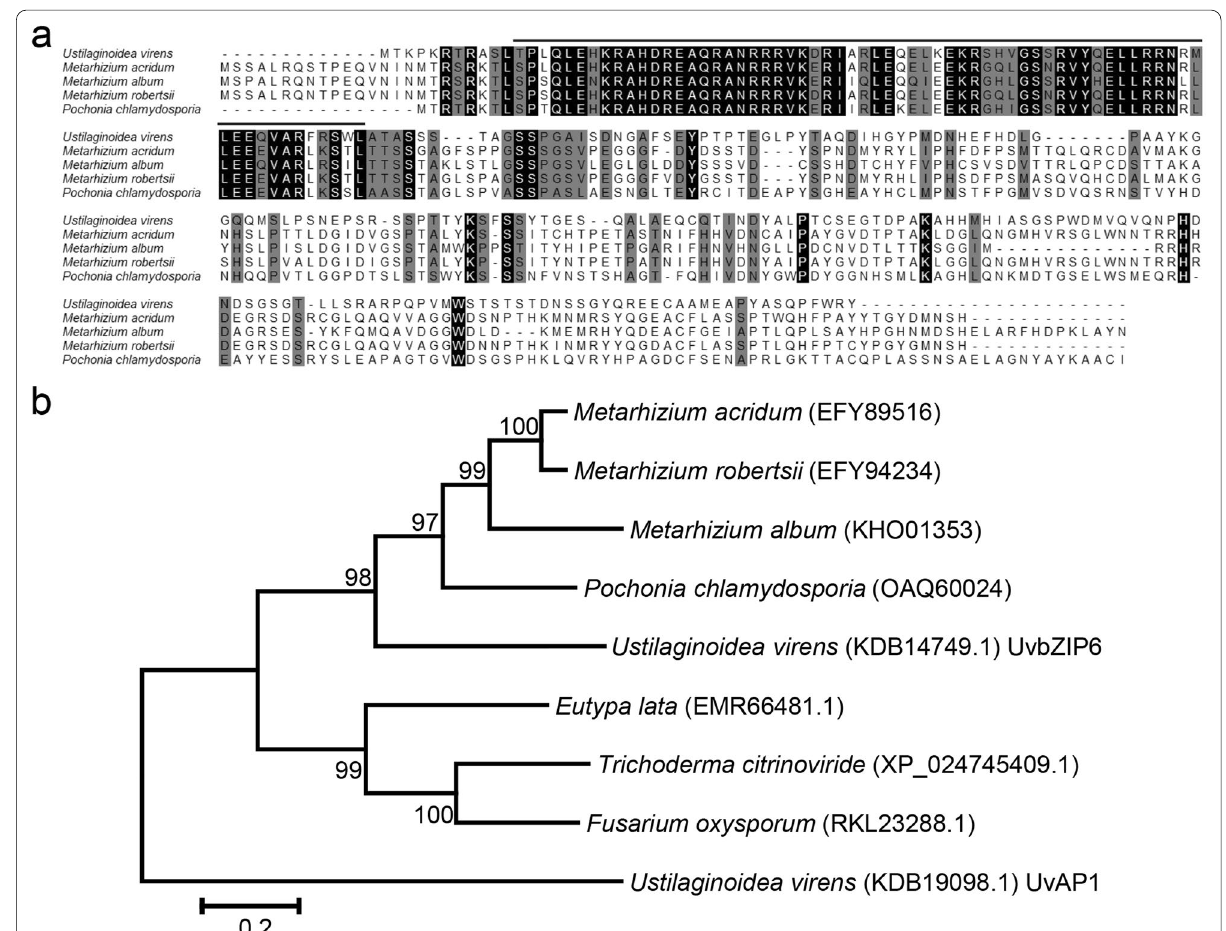
Fig. 1 Alignment and phylogenetic analysis of UvbZIP6. a Sequence alignment of UvbZIP6 and its orthologs from five different fungal species. The bZIP domain sequence indicated by the line was predicted using the SMART website. b Phylogenetic analysis of UvbZIP6. The phylogenetic tree was constructed using MEGA7, and UvAP1 (KDB19098) was used as the